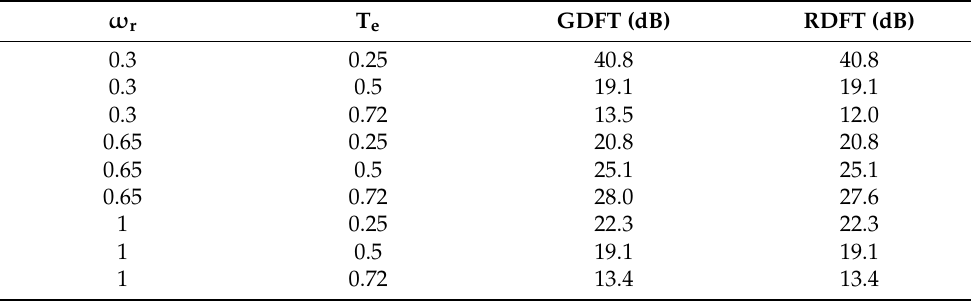
Table 2. Amplitudes of the rotor-fault-related harmonic at vector